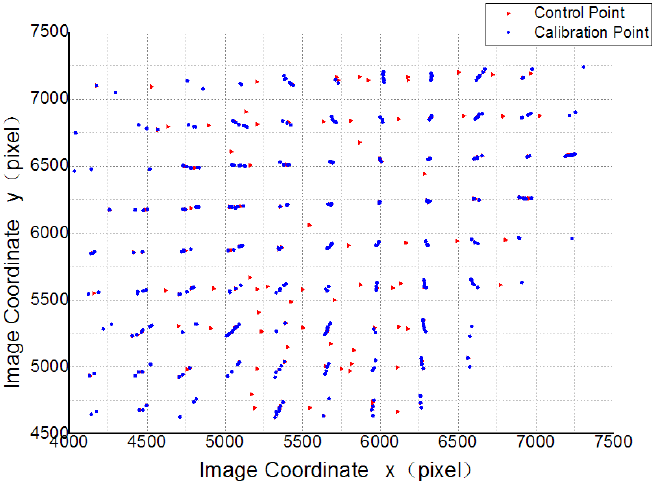
Figure 6. The selection results of control points set.